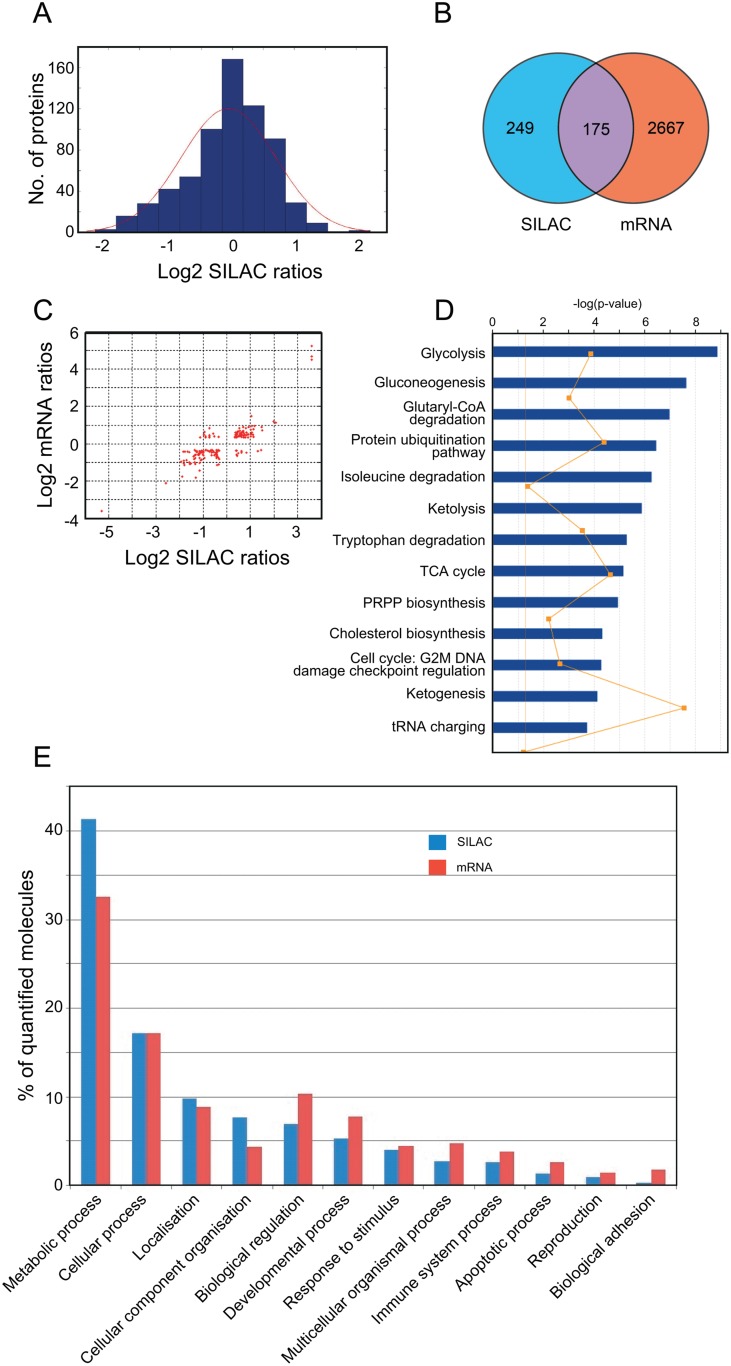
SILAC and mRNA quantitative profiling.(A), histogram of log2 SILAC ratios. (B), Venn diagram of DEGs identified in SILAC and mRNA analyses (threshold 1.25 fold change). (C), Scatter plot illustrating fold change relationships between DEGs identified in SILAC and mRNA analyses. (D), Most affected canonical pathways as identified by IPA analysis of SILAC data (threshold 1.25x change). The orange line represents the ratio of the number of genes represented within each pathway to the total number of genes in the pathway. (E), Distribution of DEGs in GO: biological process categories.